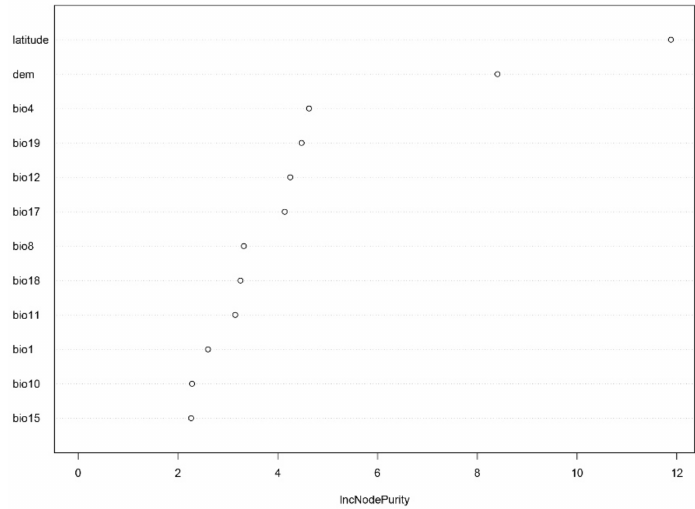
Figure 3. Importance scores for each environmental variable used as input in the random forest algorithm model. The increase in node purity is calculated based on the reduction in sum of squared errors whenever a variable is chosen to